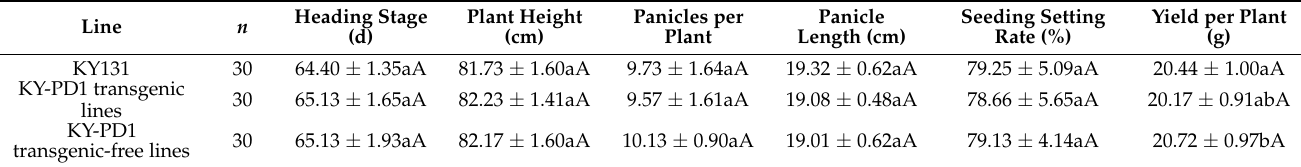
Table 4. Main agronomic traits of KY-PD1 in the T 2